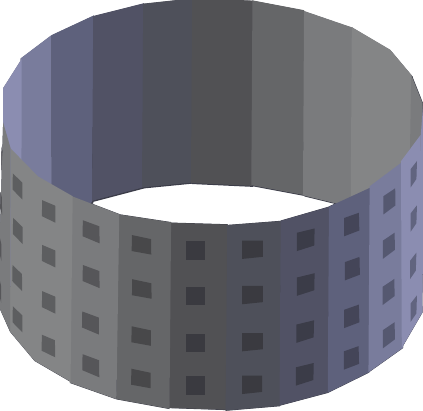
Figure 1: Conventional cellular network with fixed infrastructure (a); and mobile ad hoc network (b).